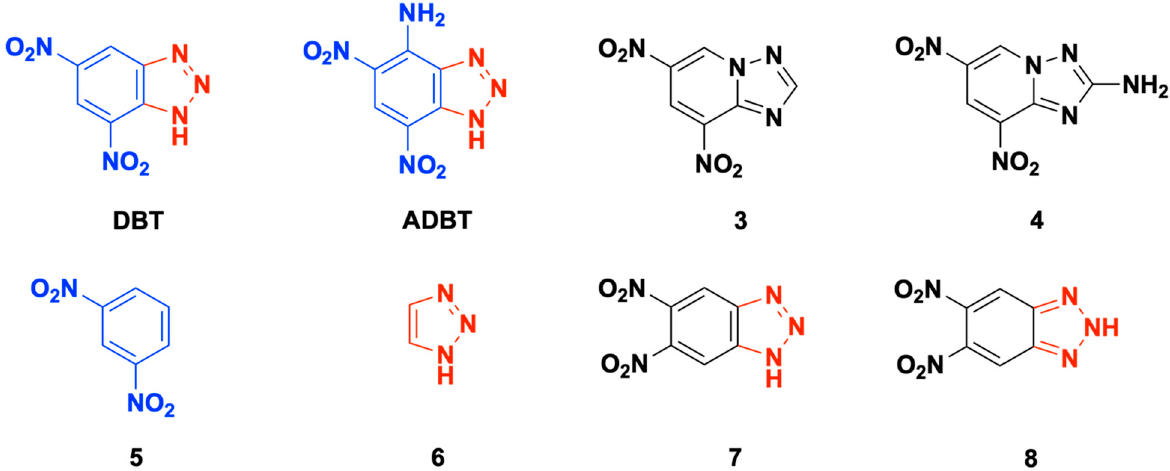
Figure 1. Molecular structure of 5,7-dinitrobezotriazole ( DBT ), 4-amino-5,7-dinitrobezotriazole ( ADBT ), and its structural isomers 6,8-dinitrotriazolopyridine ( 3 ) and 2-amino-6,8-dinitrotriazolopyridine ( 4 ), their simpler congeners 1,3-dinitrobenzene ( 5 ) and 1,2,3-triazole ( 6 ), and the tautomeric form of 5,6-dinitrobenzotriazole 1H - ( 7 ) and 2H-form ( 8 ). The dinitrobenzene part of the DBT and ADBT is colored blue, and the triazole one is red.